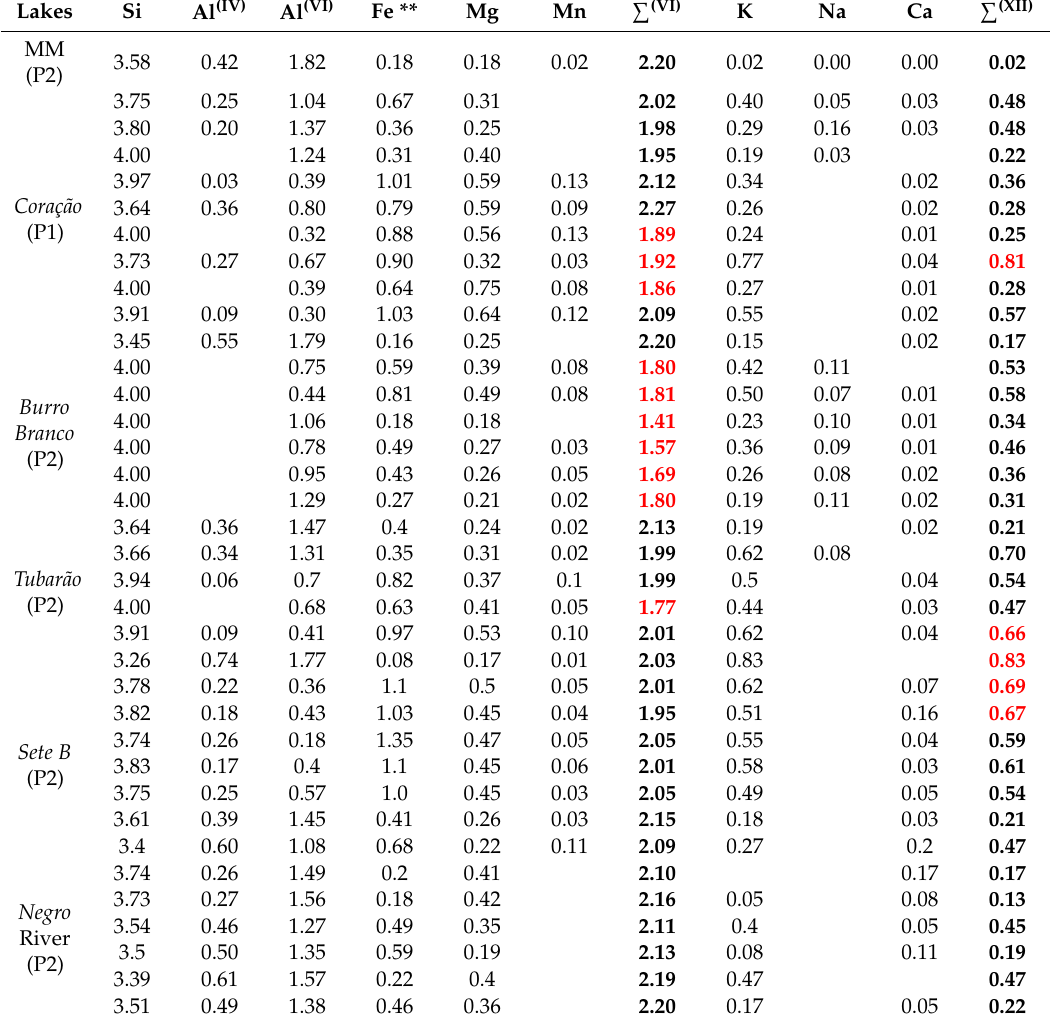
Table 7. Chemical analyses obtained by analytical electron microscopy (AEM) and expressed as